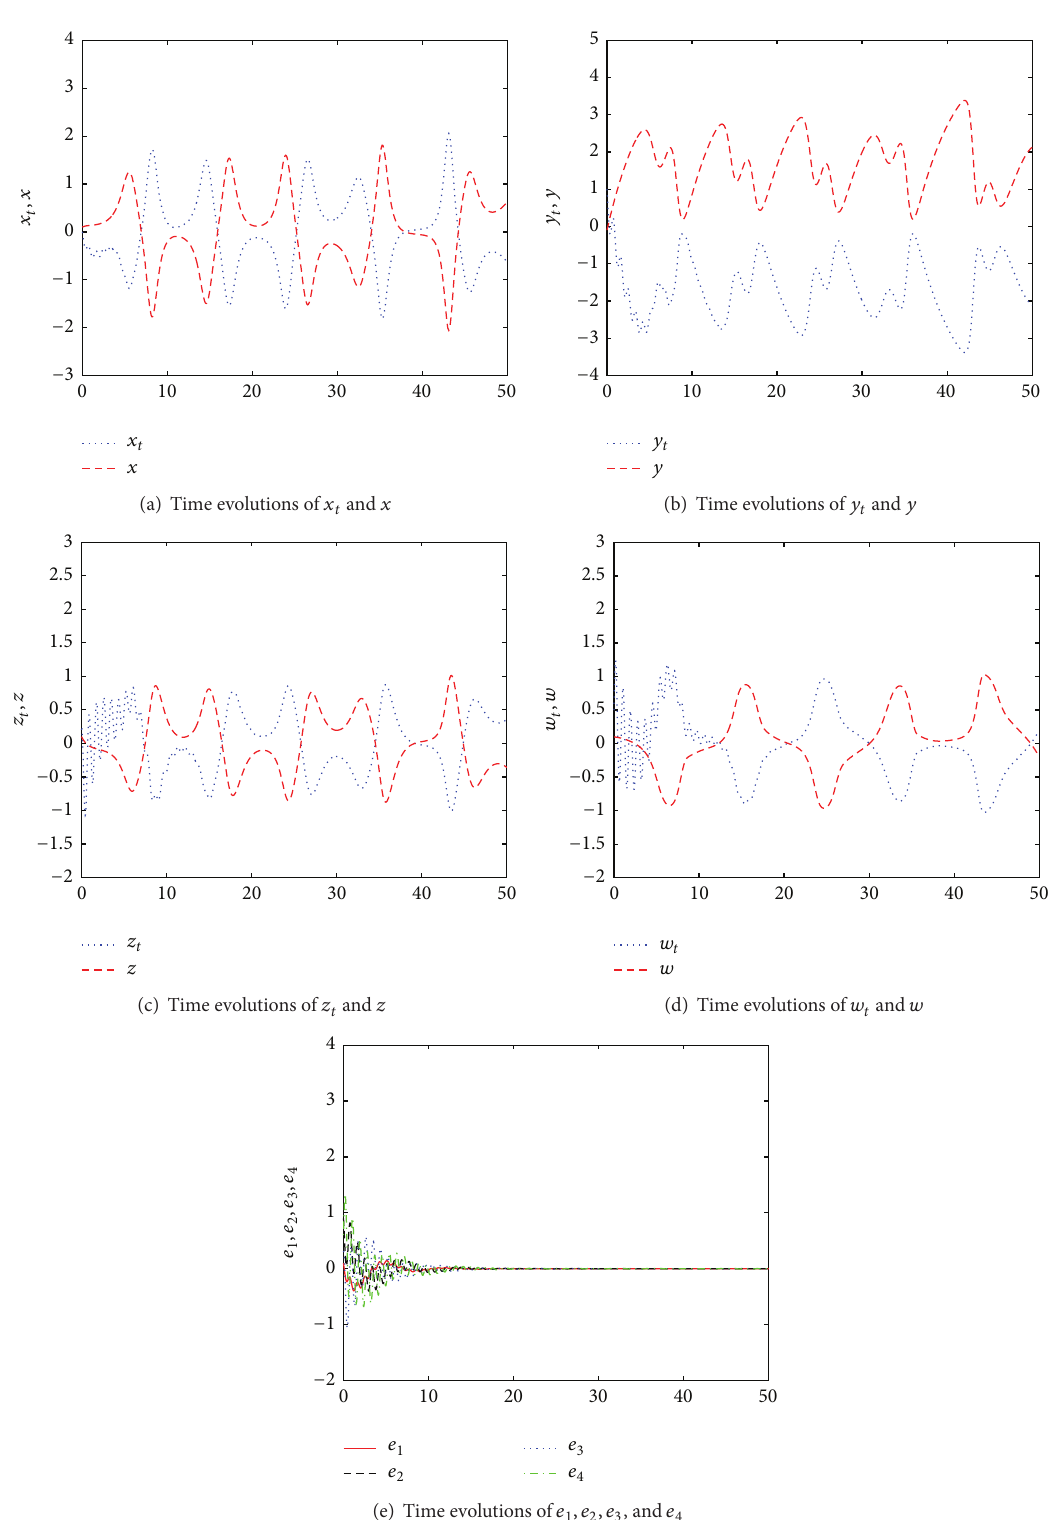
Figure 4: Time evolutions of the state variables of system (3) and system